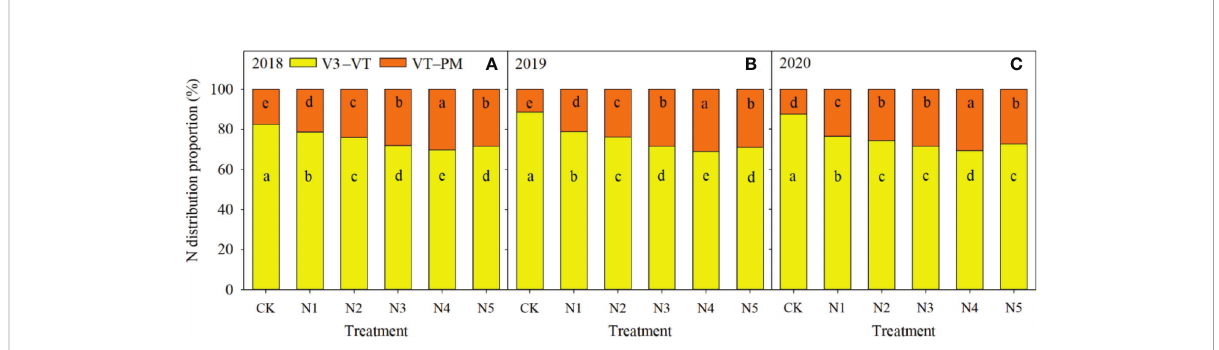
FIGURE 3 Nitrogen (N) distribution in different growth periods in different N application treatments in 2018 (A) , 2019 (B) , and 2020 (C) . Different letters in columns for each growth period in each year indicate signi fi cant differences in the proportion of N ( P < 0.05). V3, third-leaf; VT, tasseling; PM, physiological